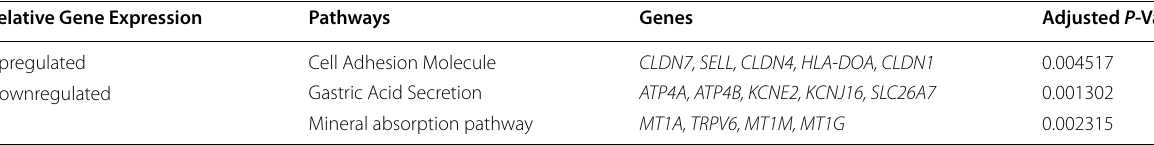
Table 3 Genes enriched in the KEGG pathway